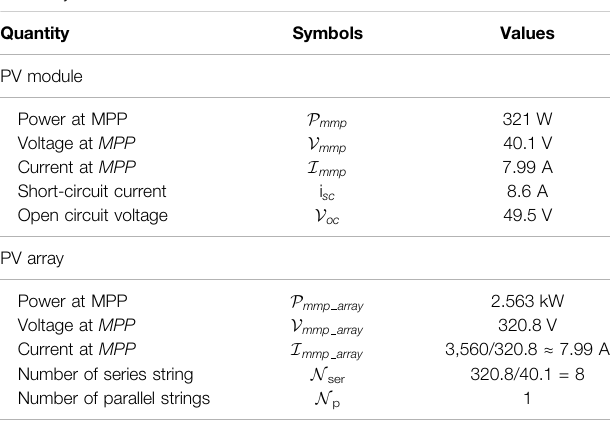
TABLE 1 | Speci fi cation parameters of Kyocera-solar KD320GX-LPB PV module and array. Quantity Symbols Values